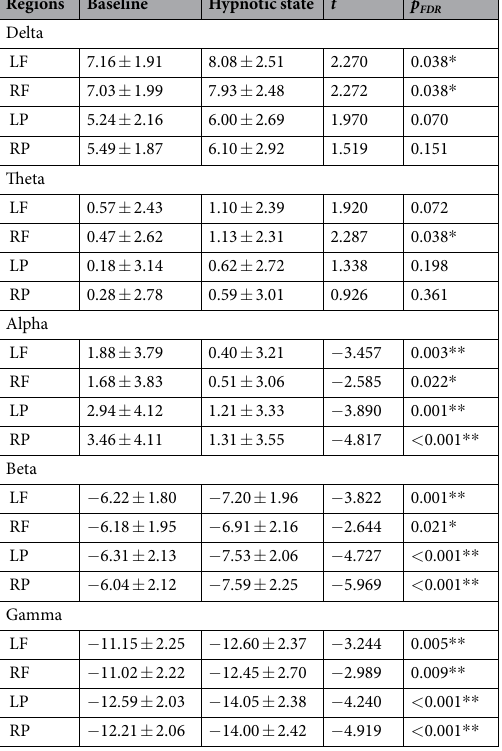
Table 1. EEG power (10 * log 10 ( μ V 2 /Hz)) in five difference frequency bands (hypnotic state > baseline). Note: * p < 0.05, ** p < 0.01.